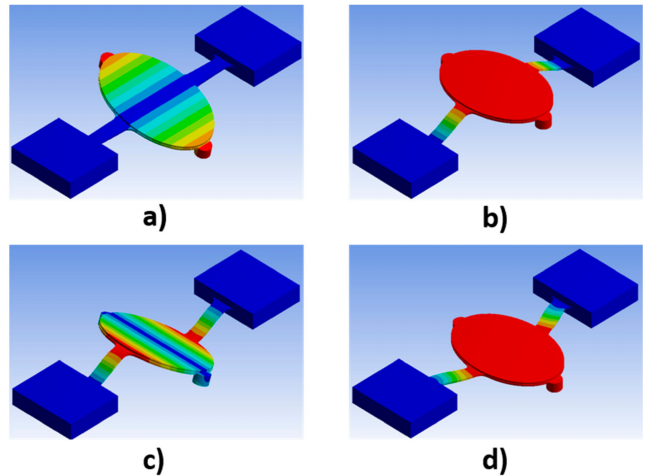
Figure 3. Resonant vibration modes of FPCB micromirror. ( a ) 1st mode; ( b ) 2nd mode; ( c ) 3rd mode; ( d ) 4th